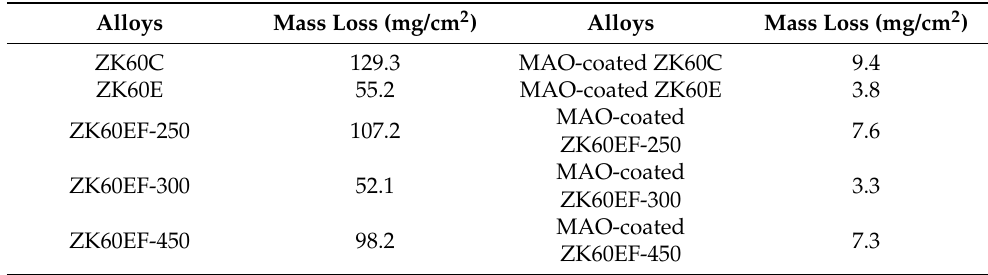
Table 1. The average corrosion rate of uncoated and MAO-coated ZK60 alloy after 35 days of salt spray test.